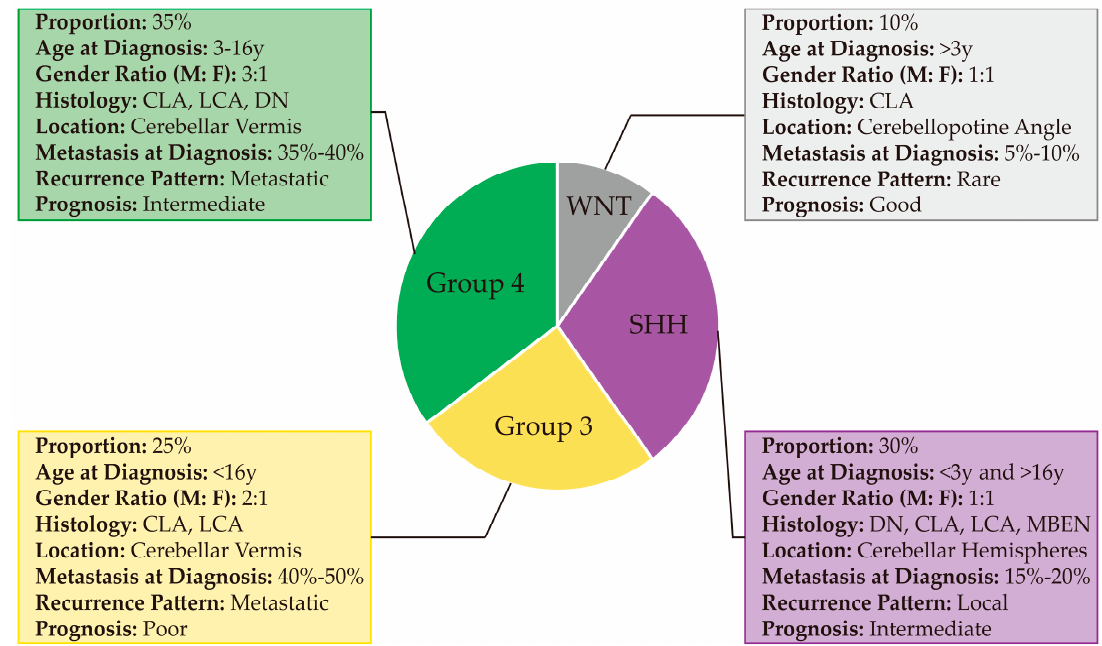
Figure 2. Clinical characteristics of MB subgroups. Pie chart illustrating the frequency, age, gender, and clinical features of the four subgroups of MB. The figure was made based on data from the following references [10,21,55 – 57].